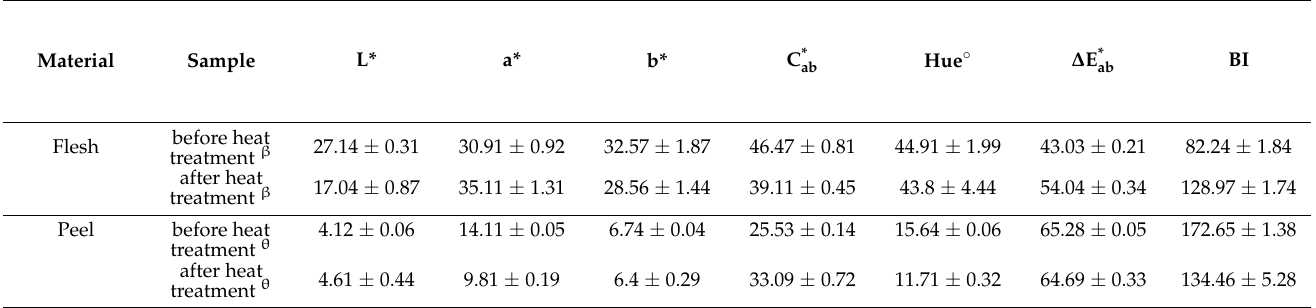
Table 5. Values of L*, a*, b*, C (cid:2911)(cid:2912)∗ , Hue°, ∆E (cid:2911)(cid:2912)∗ , and BI of the beetroot flesh and peel concentrations before and after heat treatment.